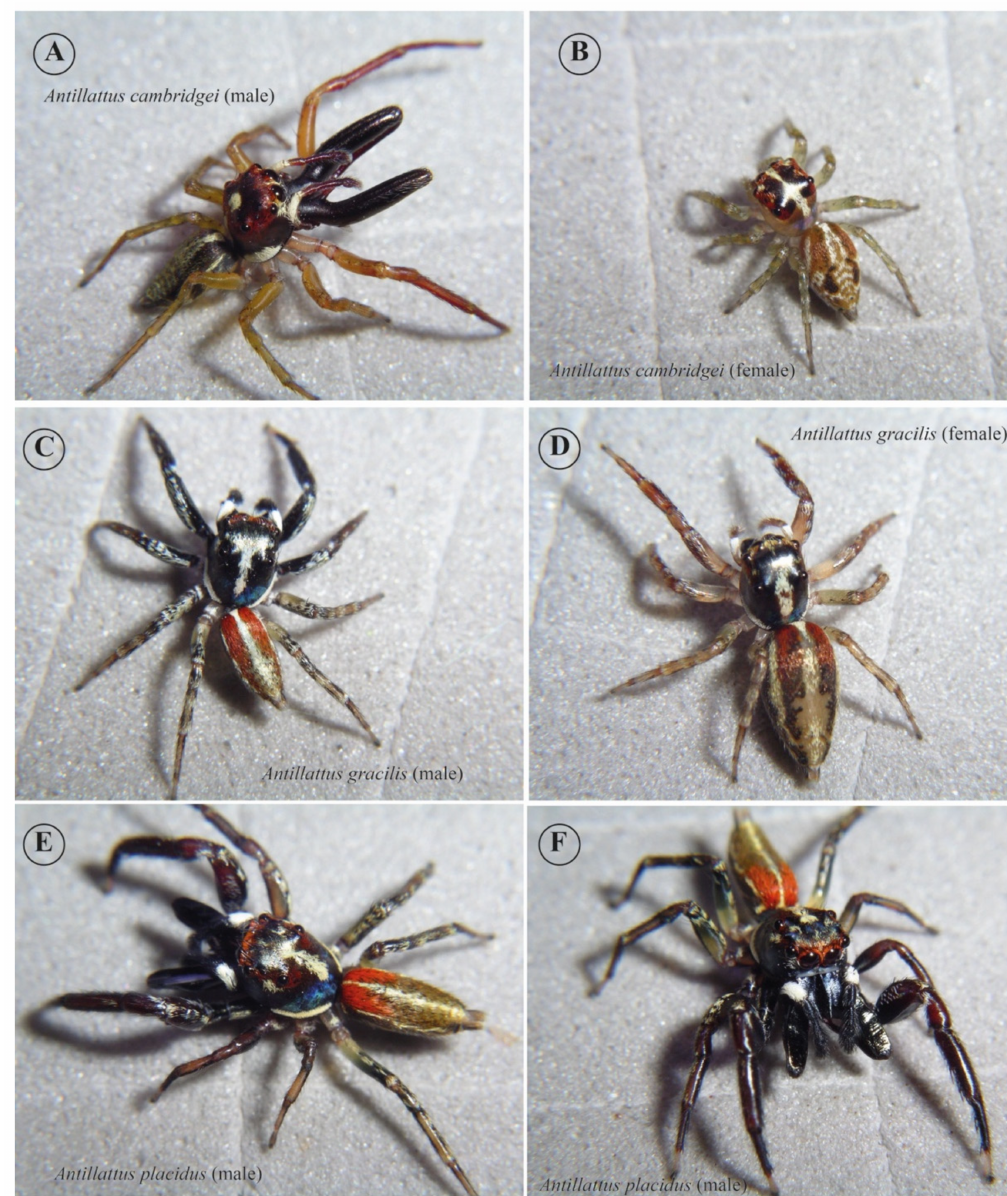
Figure 2. A – F gracilis group. ( A , B ) Antillattus cambridgei , male and female habitus. ( C , D ) Antillattus gracilis , male and female habitus. ( E , F ) Antillattus placidus , male and female habitus. Images by Wayne Maddison, released under a Creative Commons Attribution (CC–BY) 3.0